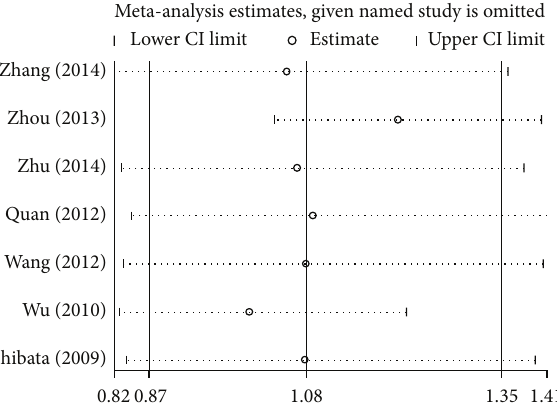
Figure 4: Sensitivity analysis through deleting each study to reflect the influence of the individual dataset on the pooled ORs in GA + AA versus GG model of IL-17A rs2275913G > A polymorphism.